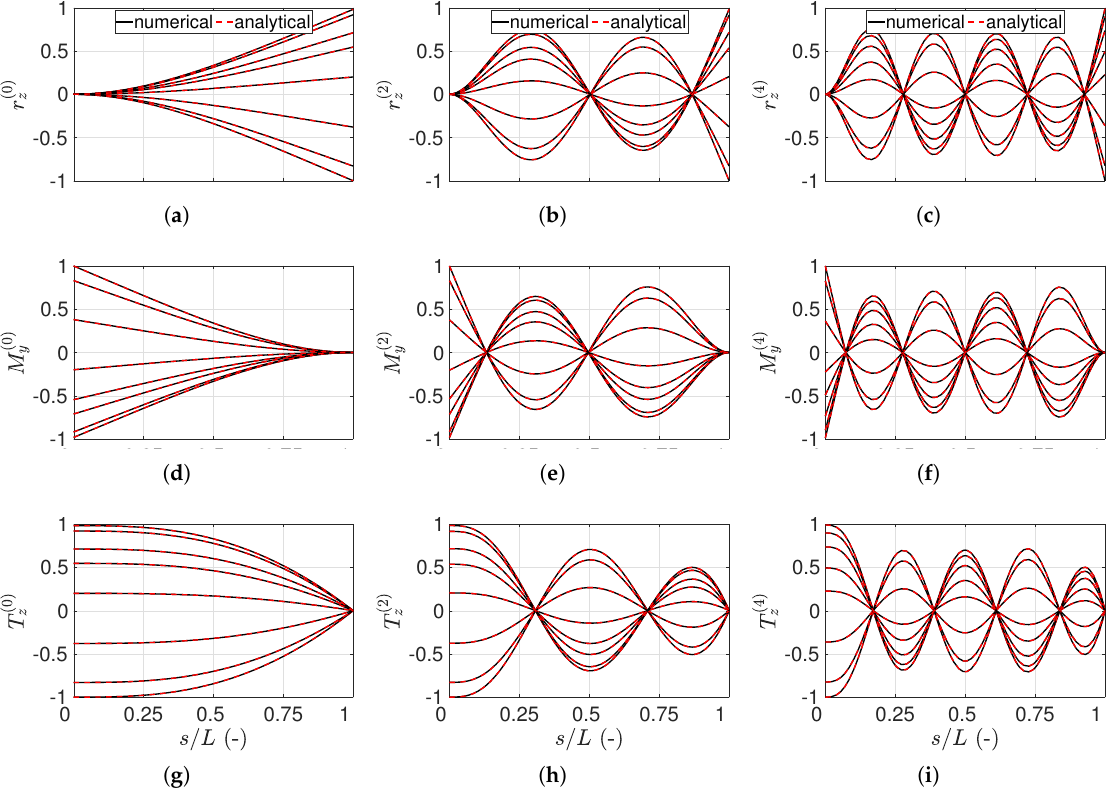
Figure 2. Normalized snap shots of a vibrating cantilever for initial mode shapes Φ 0 , Φ 2 and Φ 4 (shown in each column, respectively). Comparison between numerical and analytical results of: position r z in ( a – c ); moment M y in ( d – f ); and shear force T z in ( g – i